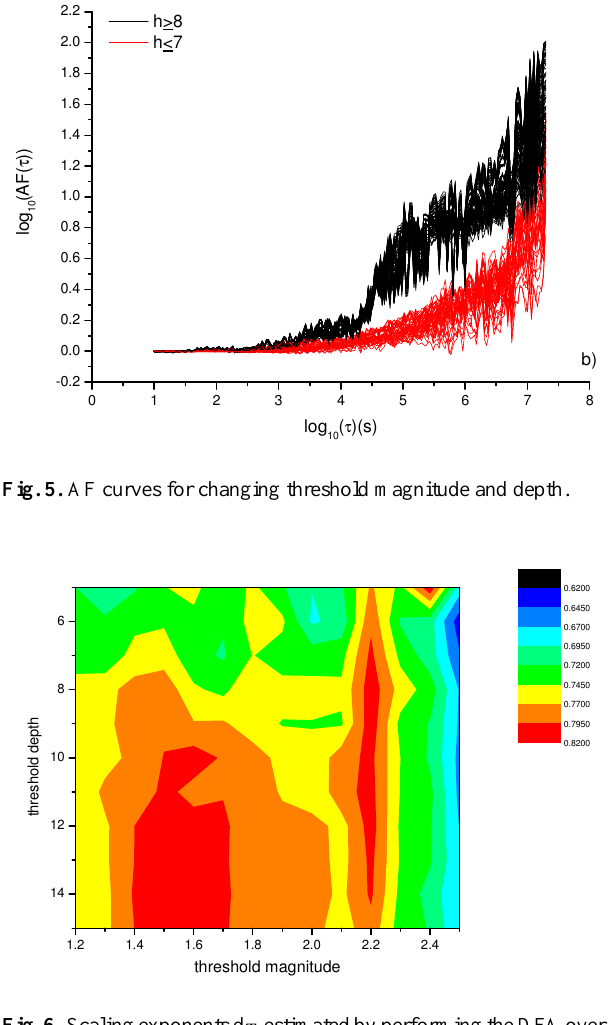
Fig. 6. Scaling exponents d T estimated by performing the DFA over the interevent time series changing the threshold magnitude and the threshold